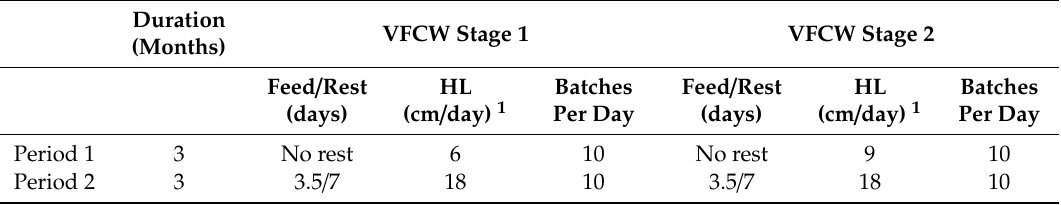
Table 2. Vertical flow CW (VFCW) operational